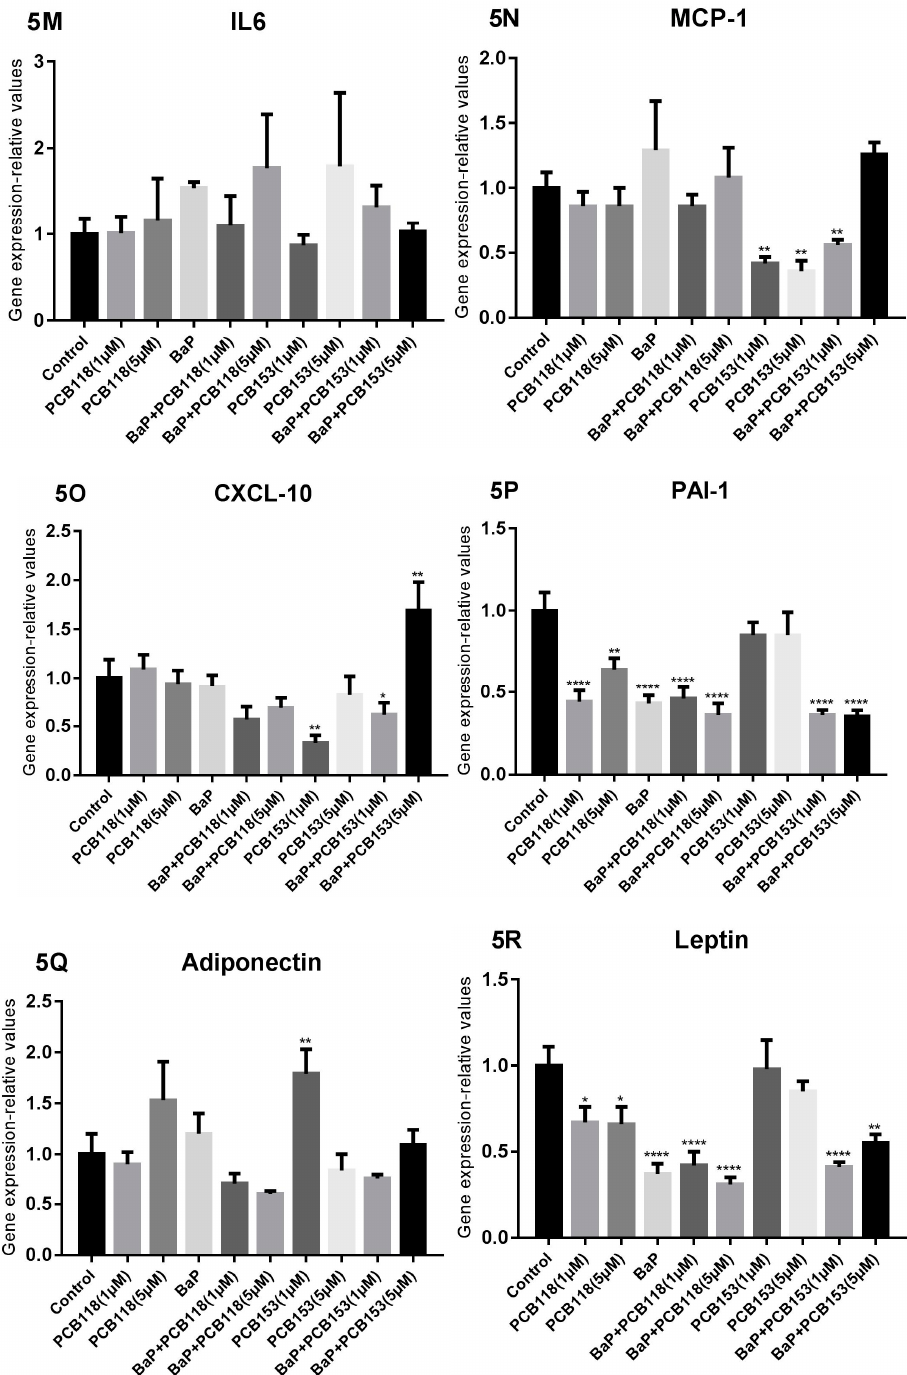
Figure 5. Effects of PCB118, PCB153 and BaP in “Time 2” conditions on the expression of genes related to adipocyte differentiation, glucose and lipid homeostasis and inflammation. 3T3-L1 cells were incubated with or without PCB118 (one or five micromolars) or PCB153 (one or five micromolars) in the presence or not of BaP (one micromolar) according to the “Time 2” conditions as described in materials and methods. Cells were washed twice with PBS and mRNA extraction and qRT-PCR were performed as described under materials and methods. Each incubation condition was carried out in quadriplicate and the experiment was repeated three times with similar results. The data are mean ± SD. The level of significance is given by comparison of treated trials with controls ( n = 4 per group): * p < 0.05; ** p < 0.01; *** p < 0.001; **** p < 0.0001.